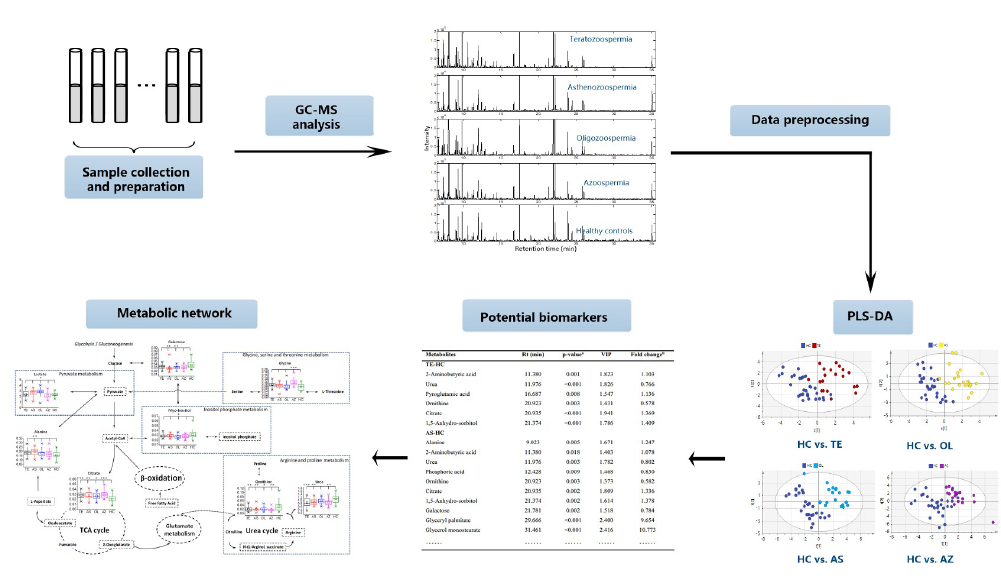
Fig 1. The workflow of metabolic analysis of SA male